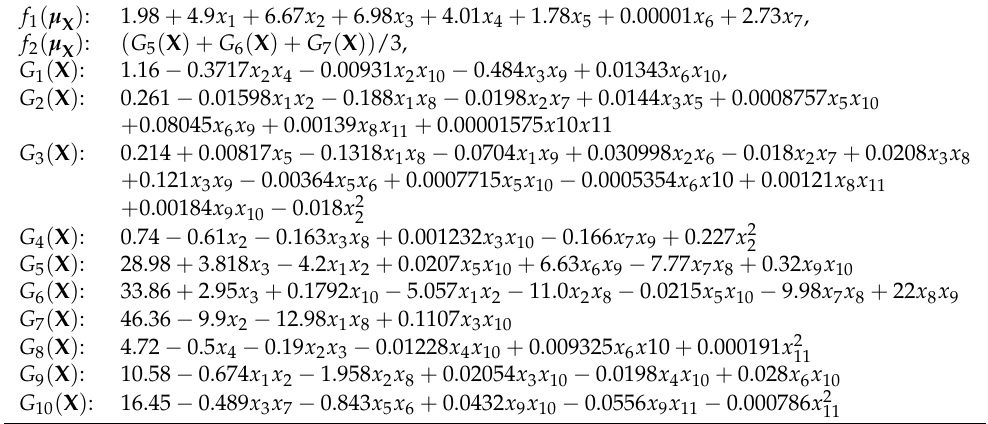
Table 6. The objectives and performance functions of Example 3.